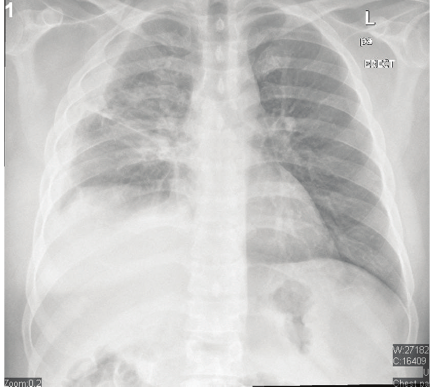
Figure 4: Chest X-ray on